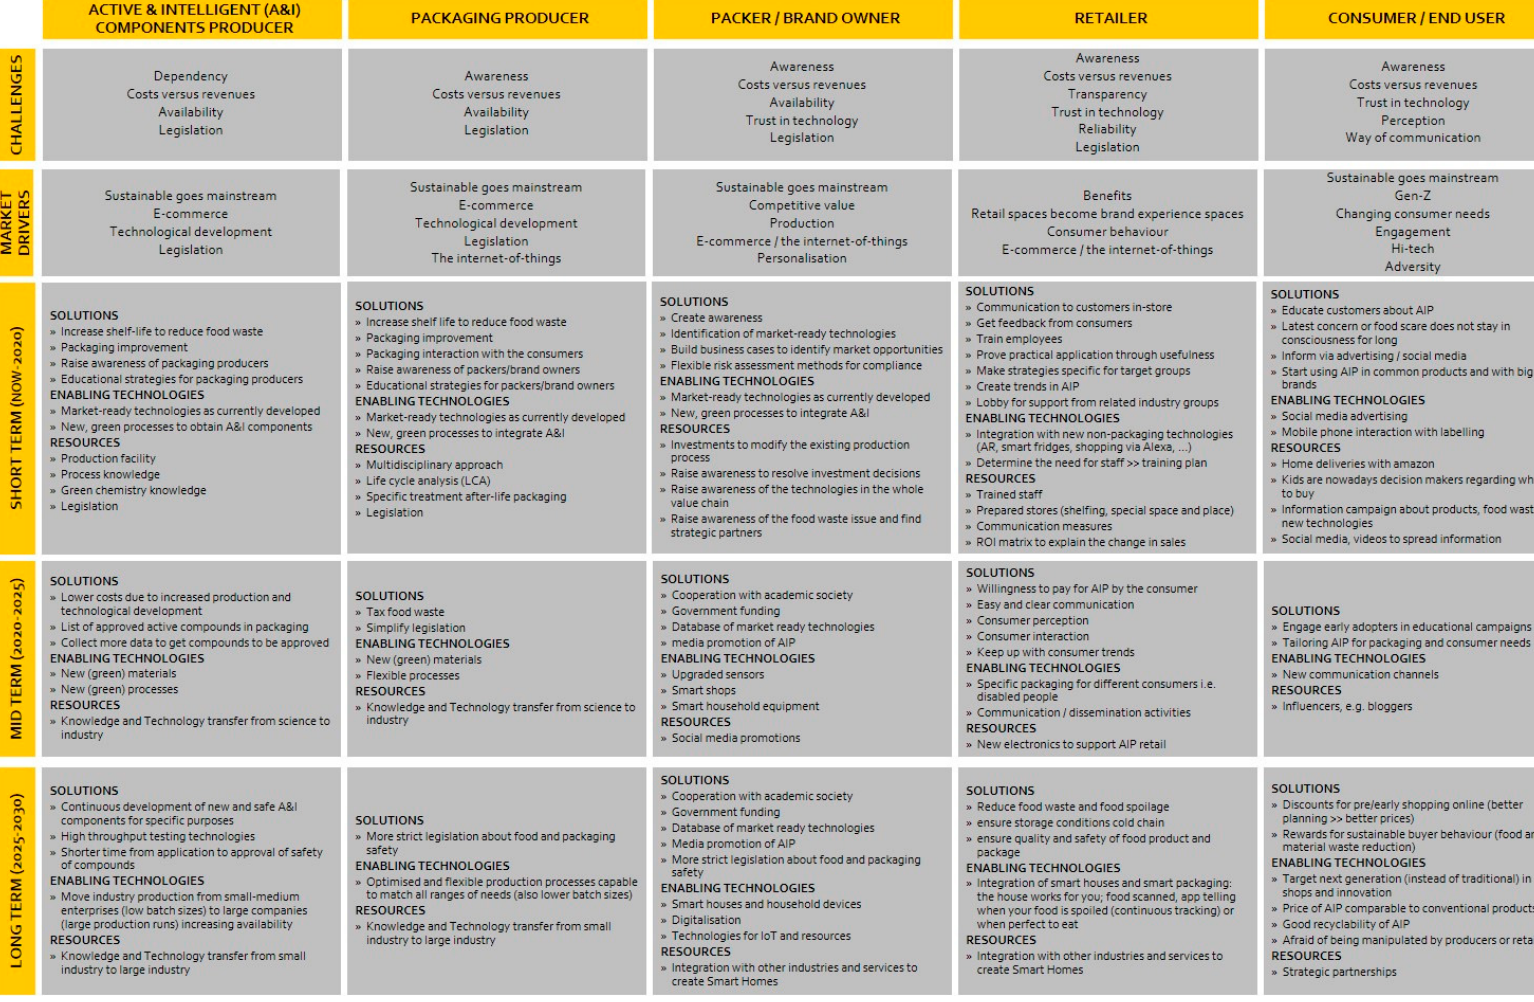
Figure 6. Socioeconomic roadmap for Active and Intelligent Packaging (AIP) composed by Working Group 2 of COST Action FP1405 ([41], Supplementary Material).